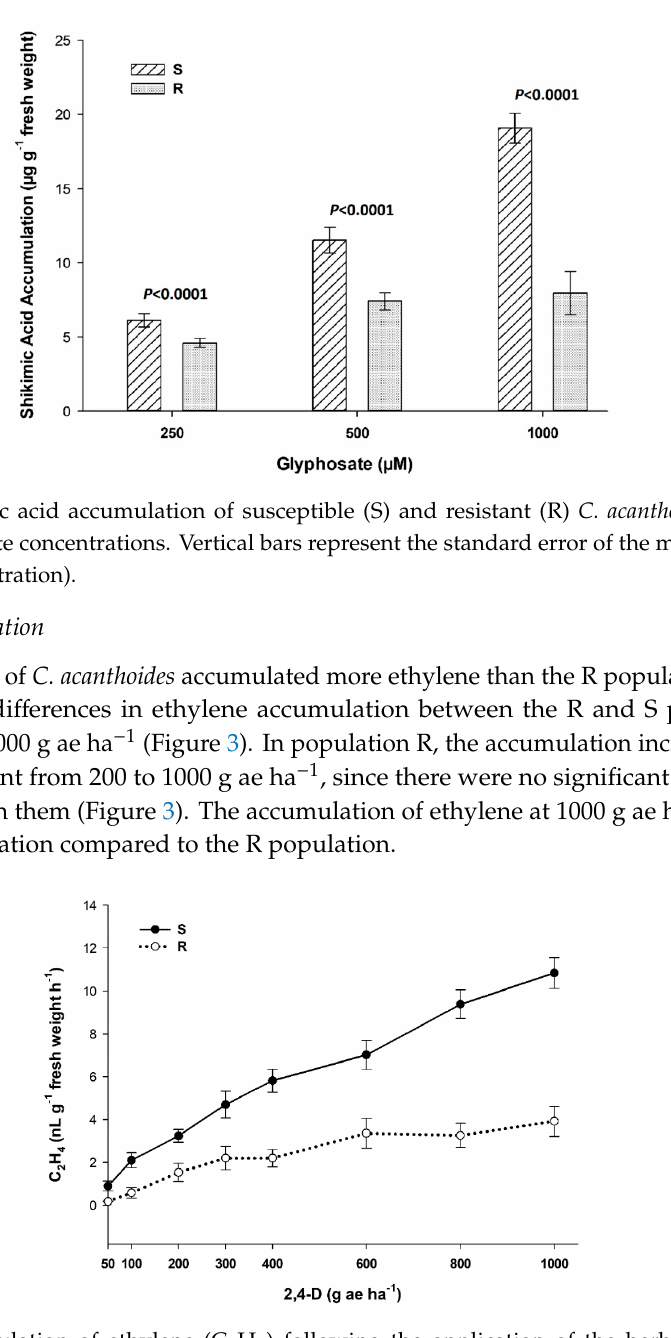
Figure 1. Dose–response curves in % reduction in fresh and dry weight ( A , C ) and % survival ( B , D ) treated with different doses of glyphosate and 2,4-D, respectively, expressed as a percentage of the mean of the untreated control of the R and S populations of C. acanthoides . Vertical bars represent the standard error of the mean ( n = 10).